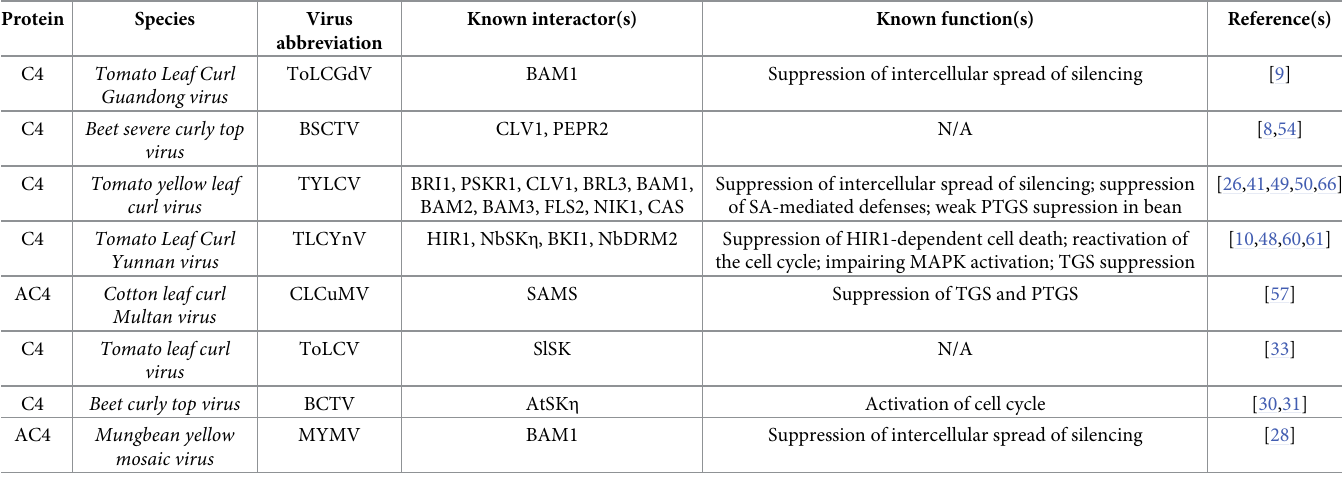
Table 2. Described plant interactors of C4/AC4